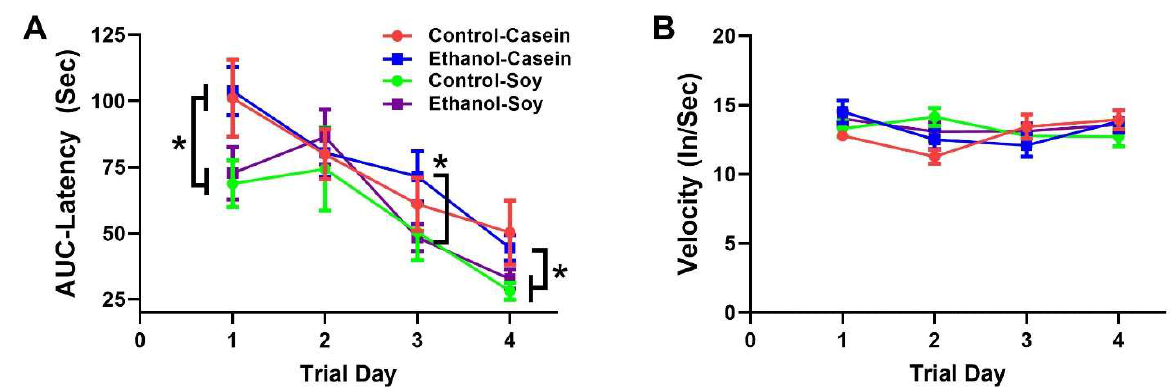
Figure 2. Effects of chronic ethanol and dietary soy isolate on Morris Water Maze (MWM) perfor- mance. MWM tests were run during the final week (Week 7) of the experiment, over 4 consecutive days with 3 trials per day per rat. Latencies to locate and land on the platform and swim velocities were video tracked and recorded, and results were analyzed using Ethovision 8.5. ( A ) Calculated area-under-curve data for latencies measured over the three daily trials were used for inter-group comparisons. ( B ) Swim velocities averaged over the 3 daily trials per rat were used for inter-group comparisons. Data from male and female rats were combined since sex differences were not observed. The two-way ANOVA test demonstrated significant effects of Trial Day and treatment (ethanol diet and soy isolate) on latency but not velocity (Table 2). In Panel A, the graphed data (mean ± S.D.) show progressive declines in latency for all groups, and significant effects of dietary soy isolate for reducing mean AUC latencies on Trial Days 1, 3, and 4 (* p < 0.05). Panel B shows no significant time-course or experimental group effects on velocity. Table 2. Ethanol and Dietary Protein Effects on Morris Water Maze Performance.